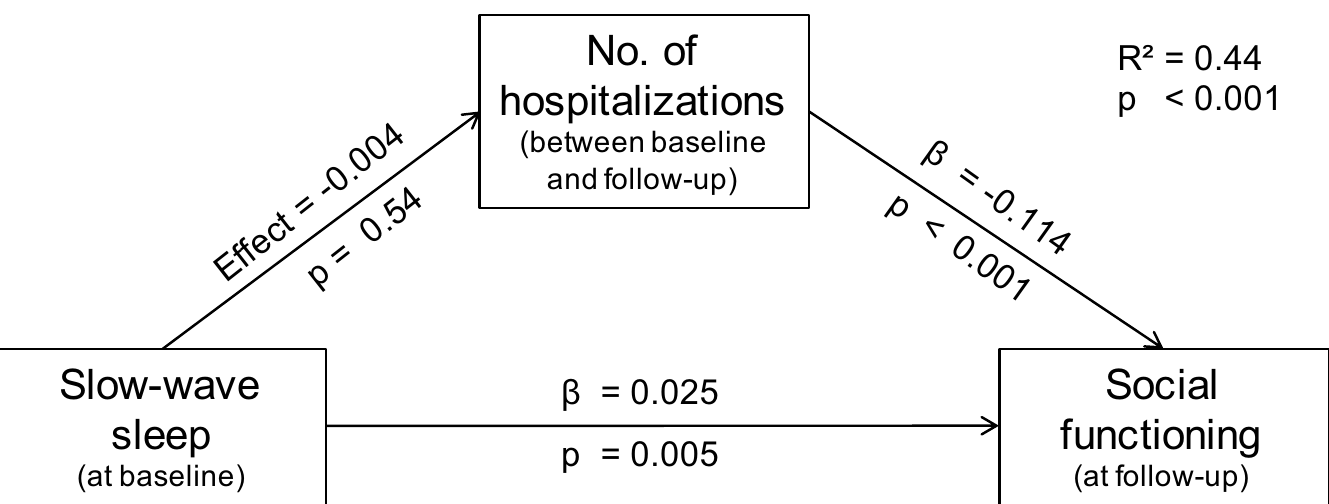
Fig 3. Bootstrapped mediation analysis. No significant mediating effect of number of hospitalizations on social functioning was found. Reported is the adjusted R 2 .